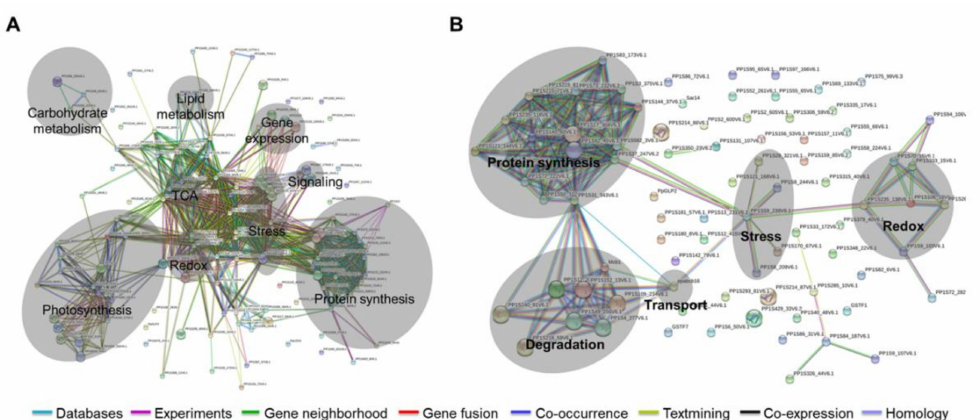
Figure 4. The Search Tool or the Retrieval of Interacting Genes (STRING) bioinformatic analysis of significantly accumulated proteins in P. patens after wounding. ( A ) Visualization of the protein interaction network of significantly di ff erentially accumulated proteins in wild-type P. patens after wounding. The shaded analysis networks are for photosynthesis, carbohydrate metabolism, lipid metabolism, TCA, redox, stress, gene expression, signaling, and protein synthesis. Databases and text-mining were chosen as the active prediction methods. ( B ) Visualization of the protein interaction network of significantly di ff erentially accumulated proteins in the aos mutant after wounding. The shaded analysis networks are for protein synthesis, degradation, transport, stress, and redox. Databases and text-mining were chosen as the active prediction methods.